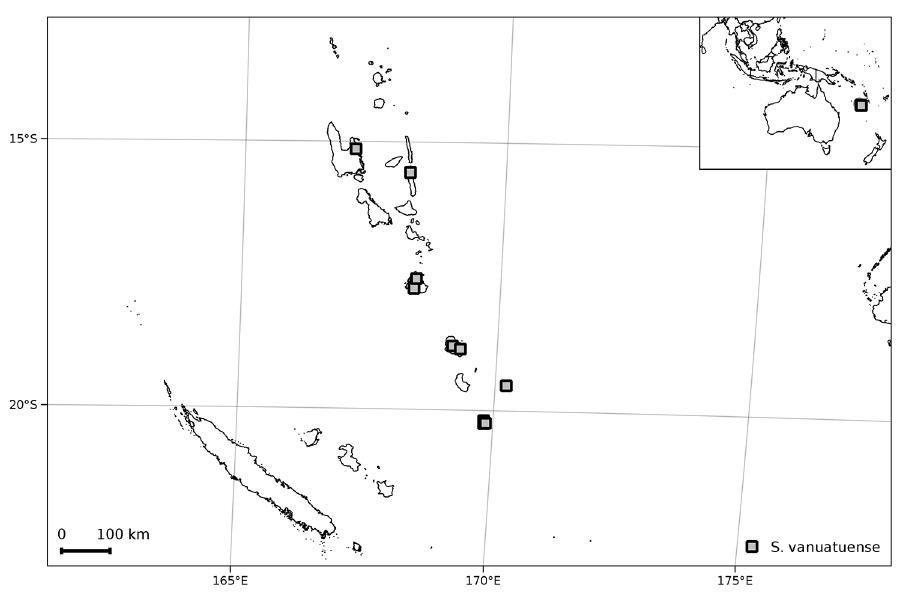
Figure 13. Distribution of Solanum vanuatuense